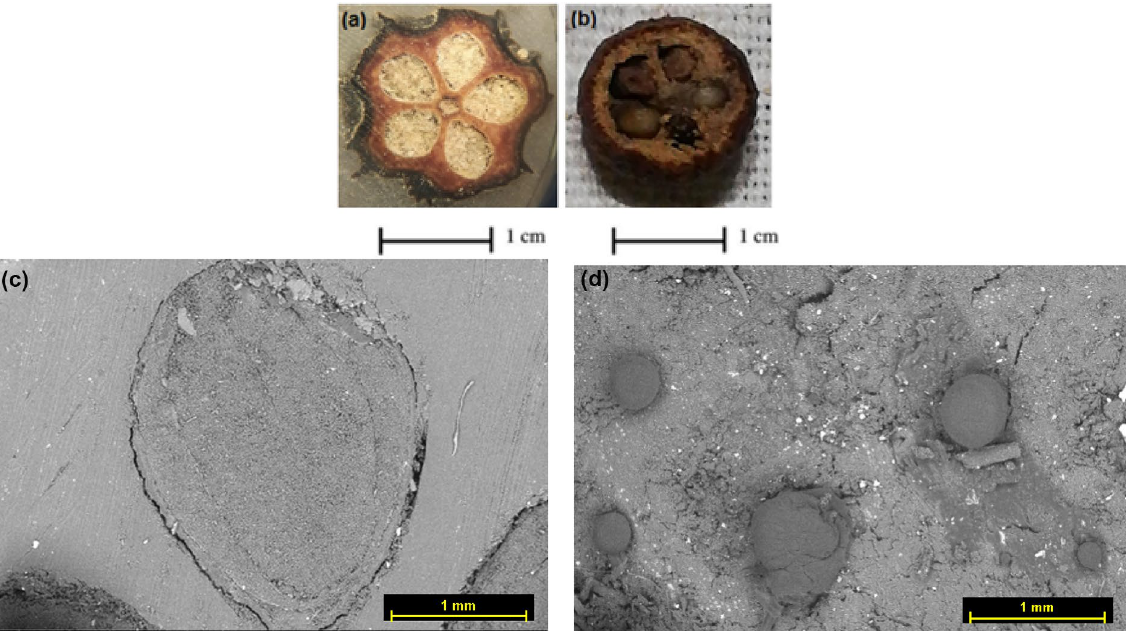
Figure 2. Transverse section of an archaeobotanical specimen, showing five seeds in a star arrangement, a scaley skin ( a ). The modern Juniper cone specimen showing similar characteristics ( b ). SEM image of archaeobotanical specimen showing seeds ( c ) and SEM image for modern dried juniper cone ( d ) at Scale bar = 1